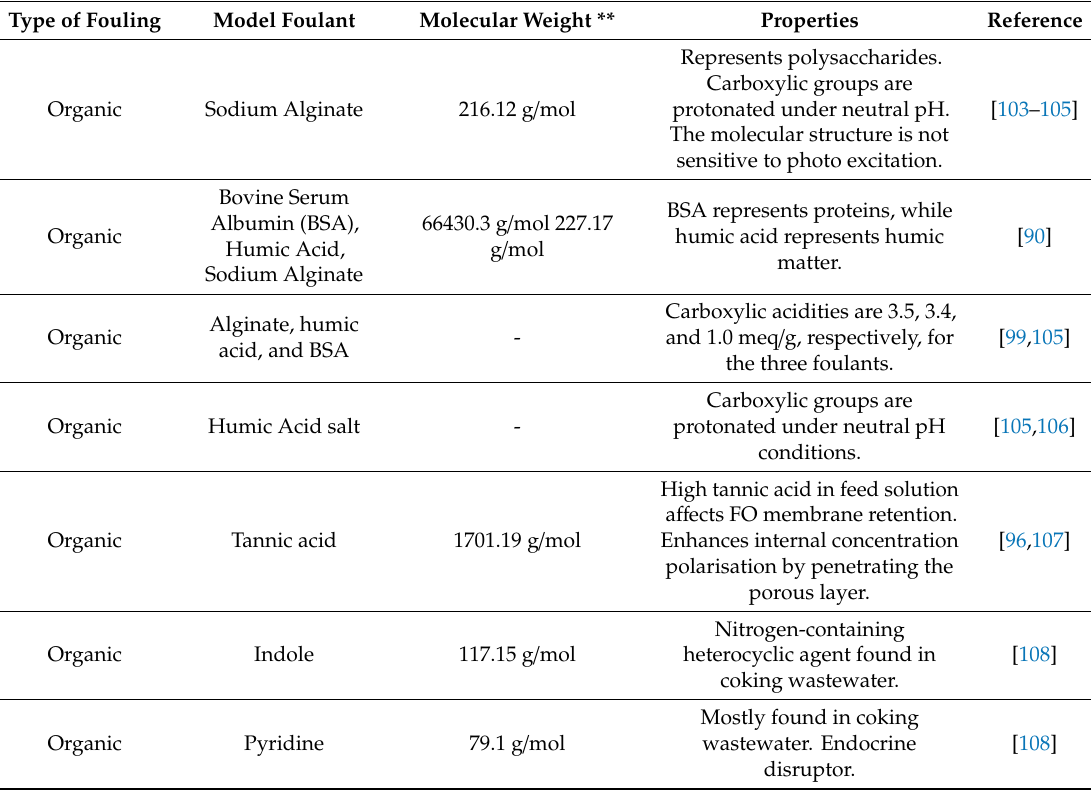
Table 1. Properties of model